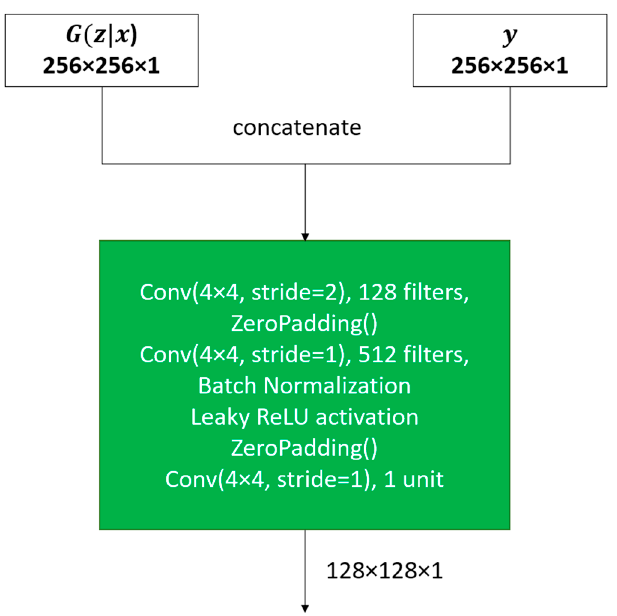
Figure 4. The architecture of the Discriminator (modified PatchGAN [15]). Note: In our case, we will concatenate z and x as input to the generator G ( z , x ) with the objective of learning the distribution of the target domain, y